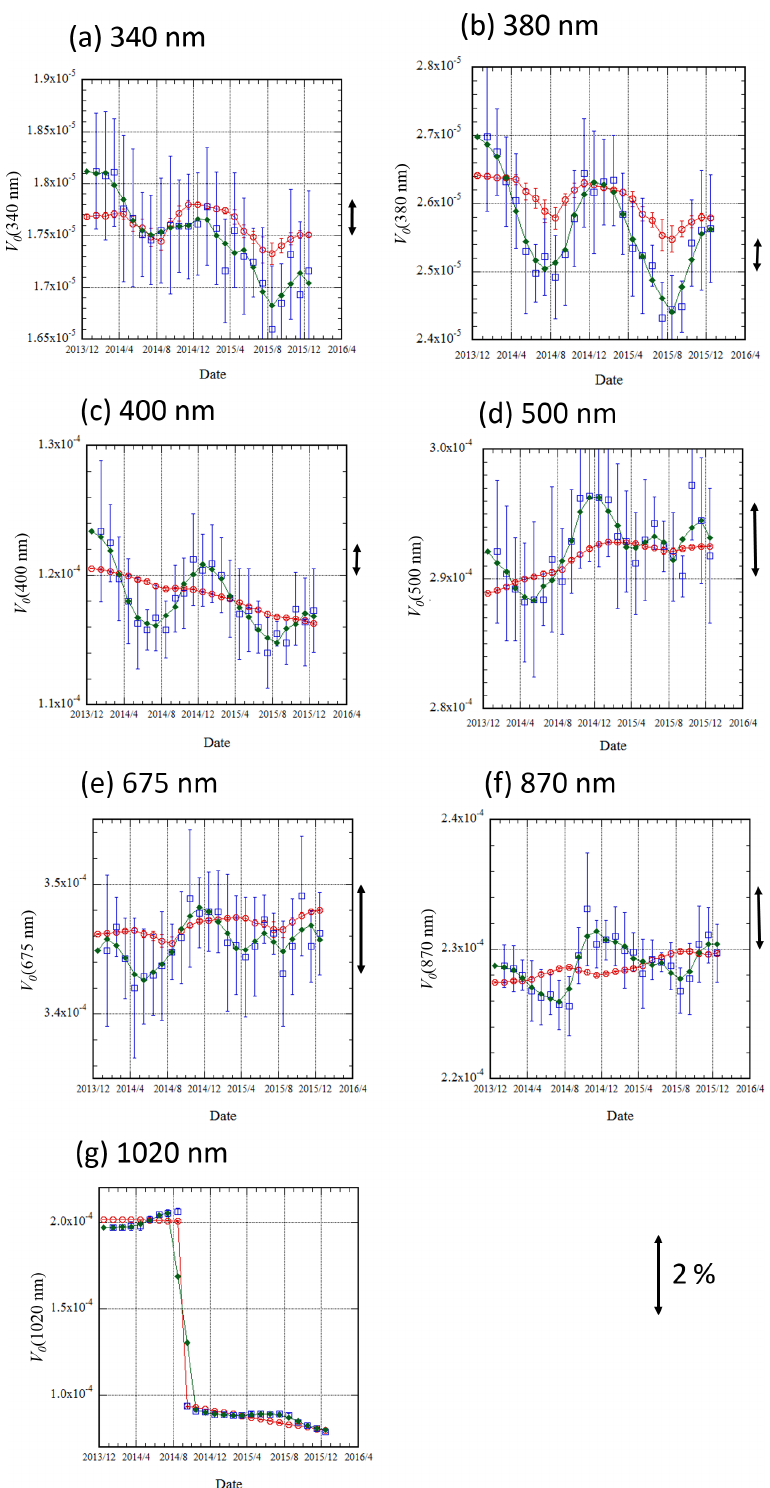
Figure 8. Time series of the calibration constant for POM-02 (Tsukuba) from January 2014 to December 2015. Blue open squares with error bars denote the calibration constants determined by the IML method. The green line shows the three-point running mean of IML, and the red line is the calibration constant interpolated from calibration constants transferred from POM-02 (calibration reference). The unit of V 0 is ampere (A). A double-headed arrow shows 2% width. A 2% scale arrow is not shown in the case of (g)